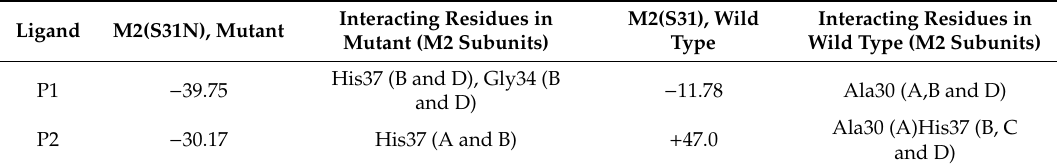
Figure 4. Summary of the expected hydrolysis fragments of chebulagic acid (P1 and P2) used for molecular modelling. Table 1. Enthalpic contributions to binding free energy of chebulagic acid hydrolysis fragments to M2, along with interacting residues and M2